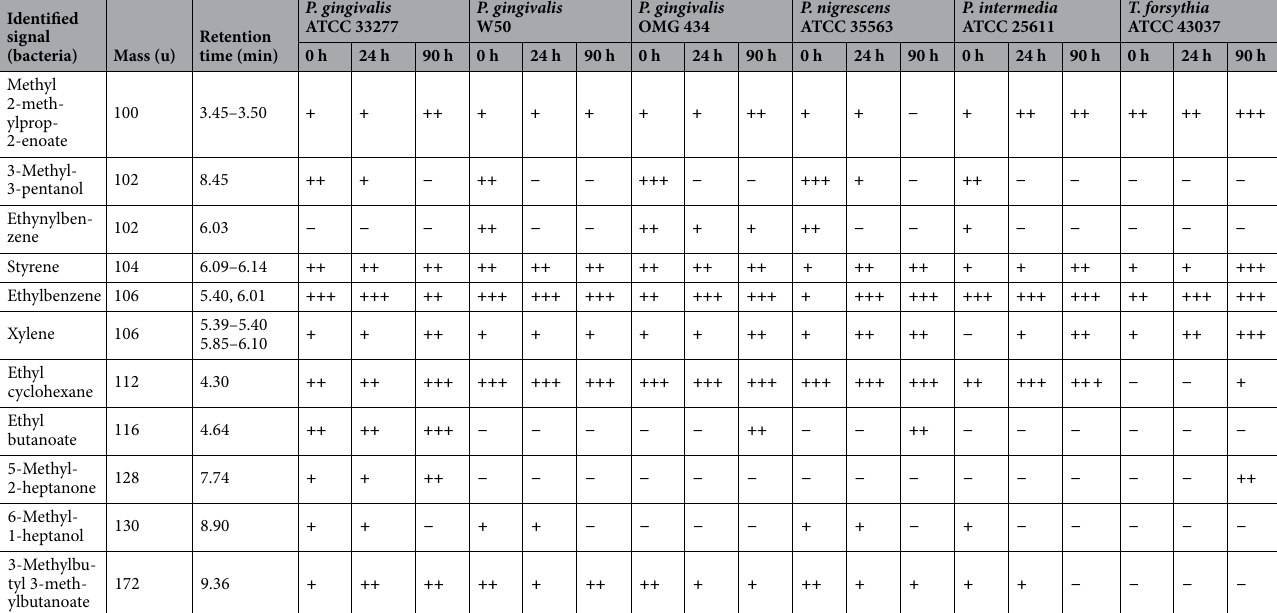
Table 1. Compounds measured and identified from the headspace of the studied oral bacteria by GC–MS. The first part of the table presents compounds solely produced by the bacteria. The latter part of the table presents compounds produced by the nutrient agar and bacteria. Markings indicate the relative signal intensity in the chromatograms (“−“ = no signal, “+” = small signal, “++” = moderate signal, “+++” = large signal). Retention times refer to chromatograms presented in the Supplementary Data of this article.